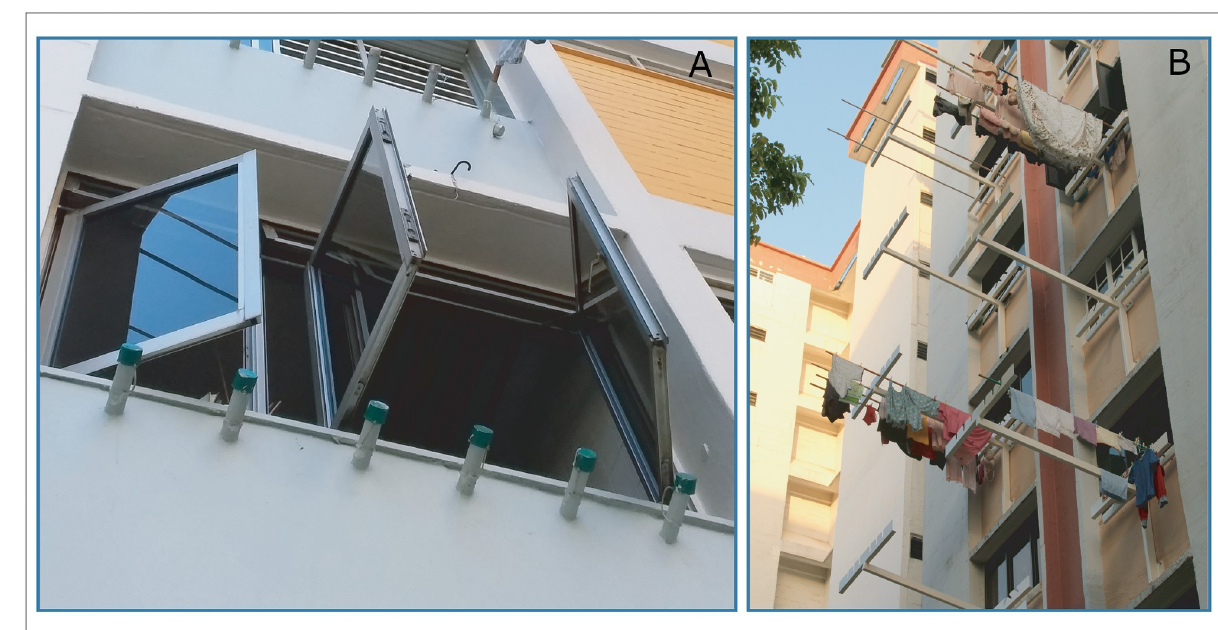
Fig 3. Redesign of washing line construction from bamboo pole holders with caps (A) to novel rack system (B).